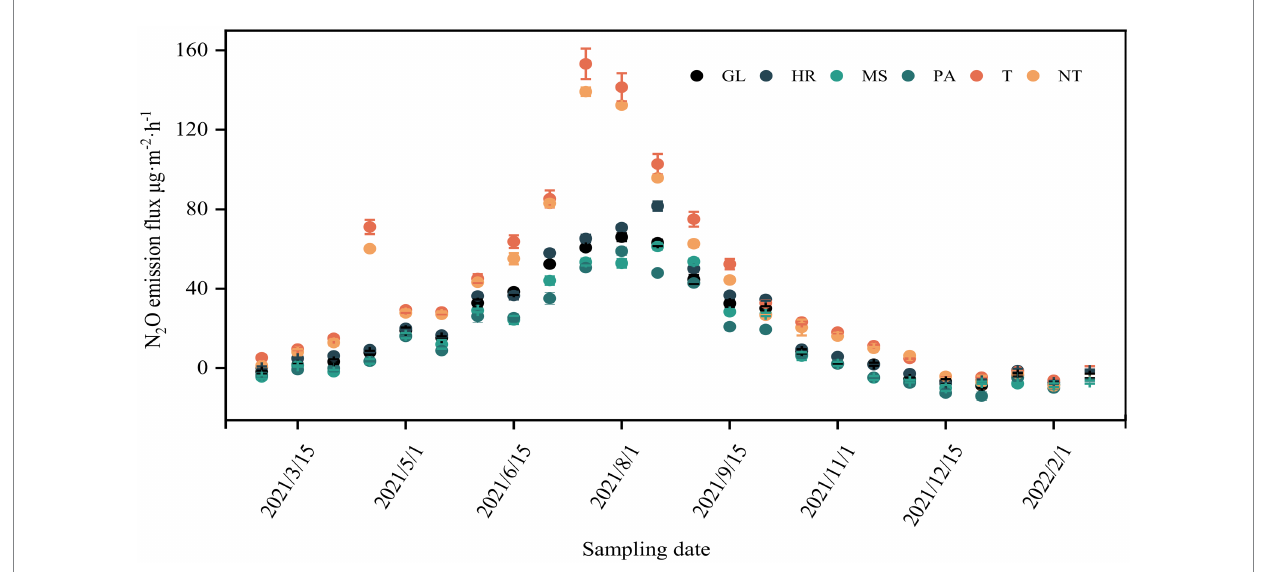
FIGURE 5 Seasonal changes of N 2 O emission under different land use patterns.